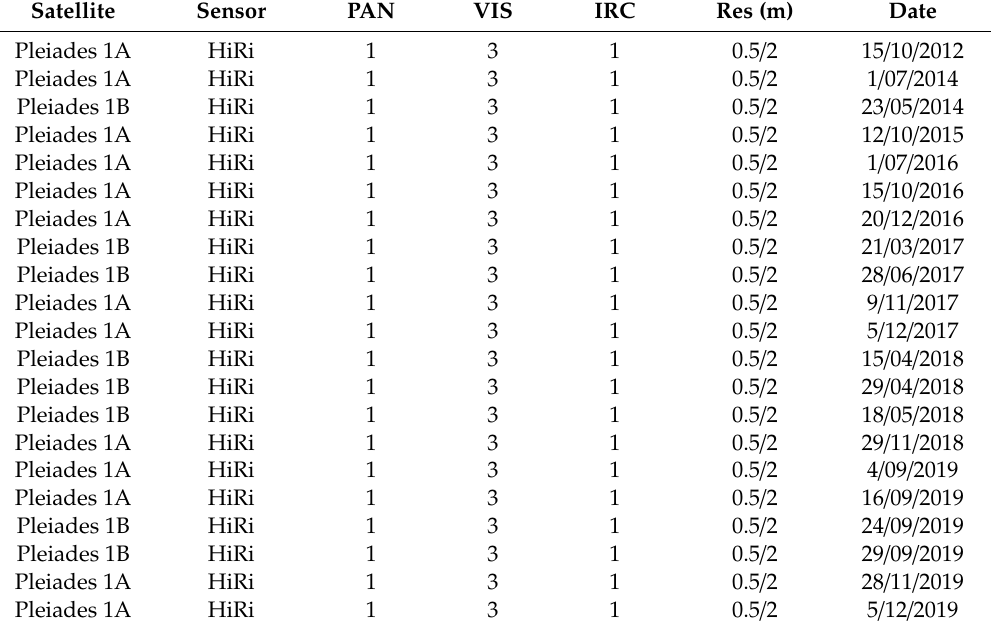
Table 2. Dates and characteristics of the images used to track the shallow water (<3 m). Satellite Sensor